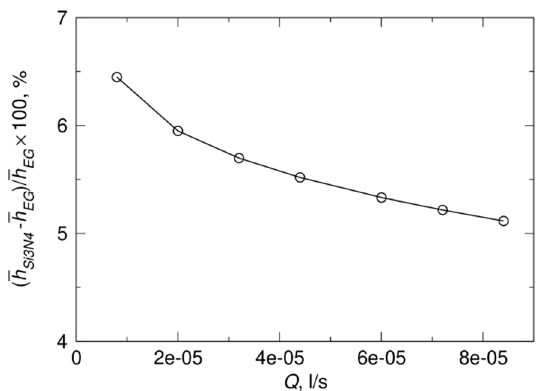
Figure 10. Computational results for the relative enhancement of the heat transfer coefficient for the EG-Si 3 N 4 nanofluid at the nanoparticle volume fraction of 3.5% over a range of nanofluid volume flow rates corresponding to Re between 200 and 2100 for pure EG.